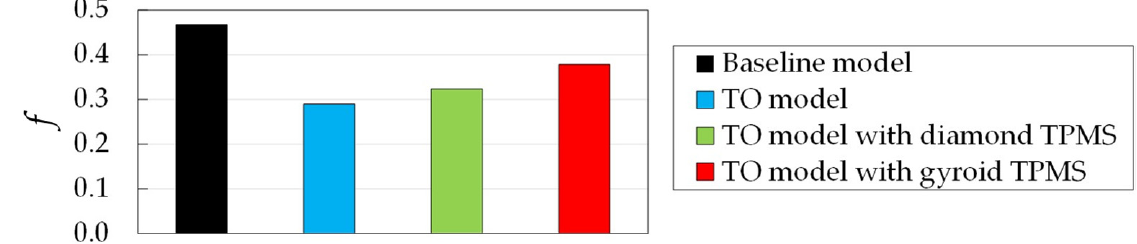
Figure 14. Friction factors for all serpentine channels at Re = 10000.